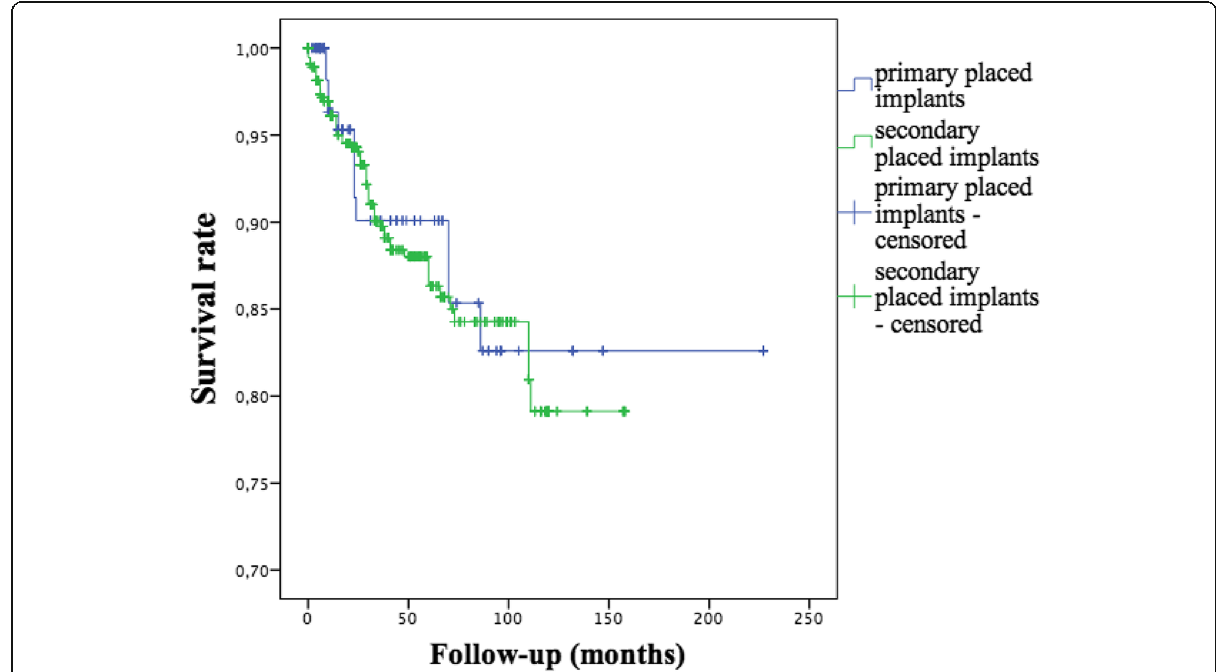
Fig. 1 Survival rates of primary and secondary placed implants (p =